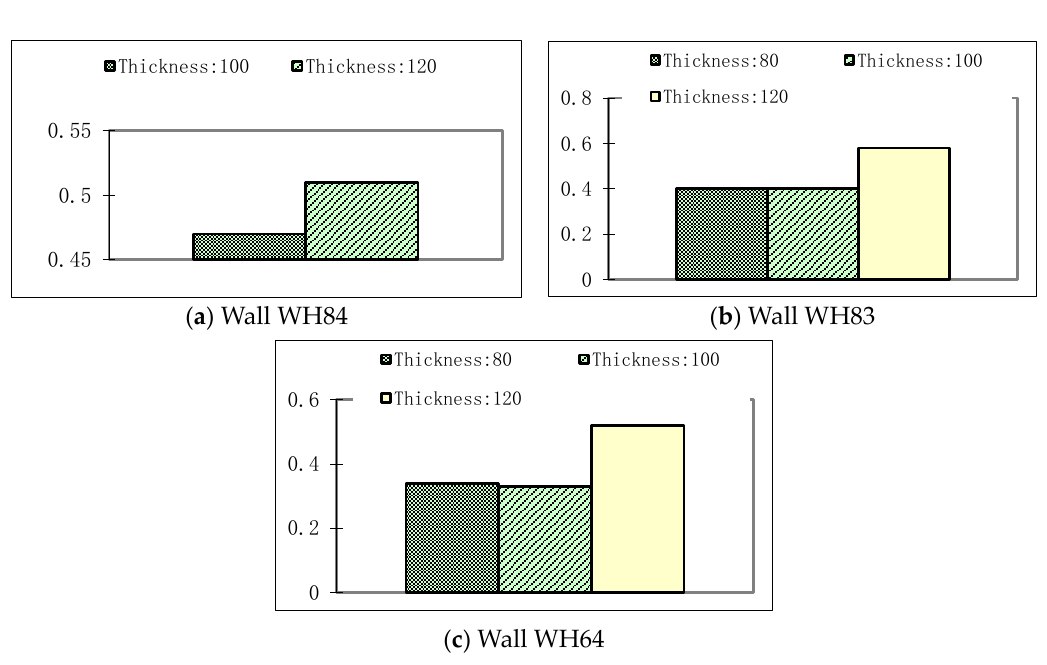
Figure 10. Load-displacement curve between inner leaf and outer leaf (LVDTs 2-5).